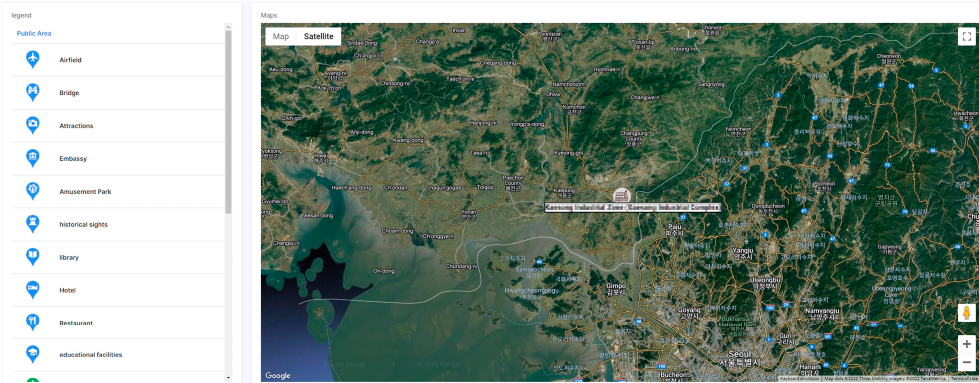
Figure 8. Visualization ② : Satellite View-based Geographic Visualization. Visualization 3 (cid:13) shows the physical network status of a specific facility in